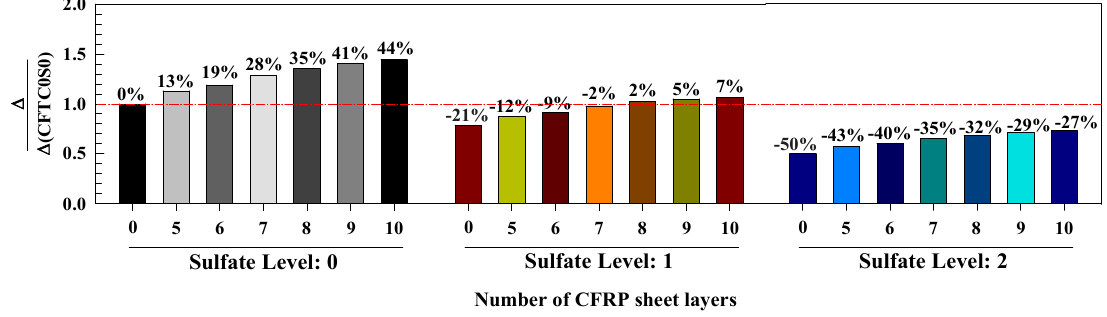
Figure 10. Effect of investigated parameters on the maximum horizontal net drift.